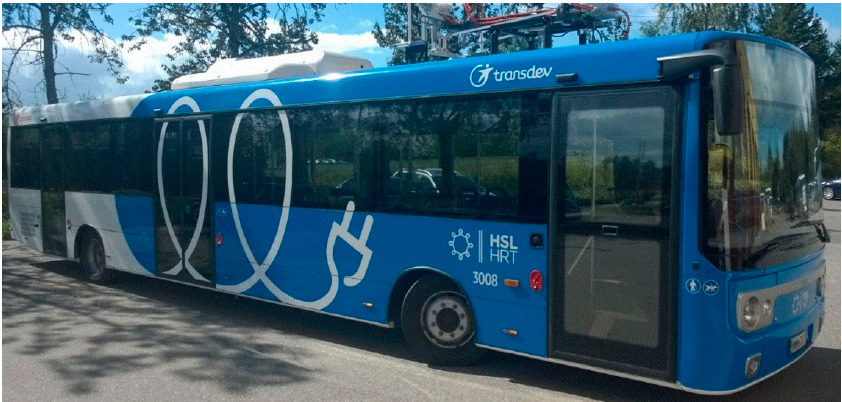
Figure 8. Linkker battery electric bus operating in Finland.